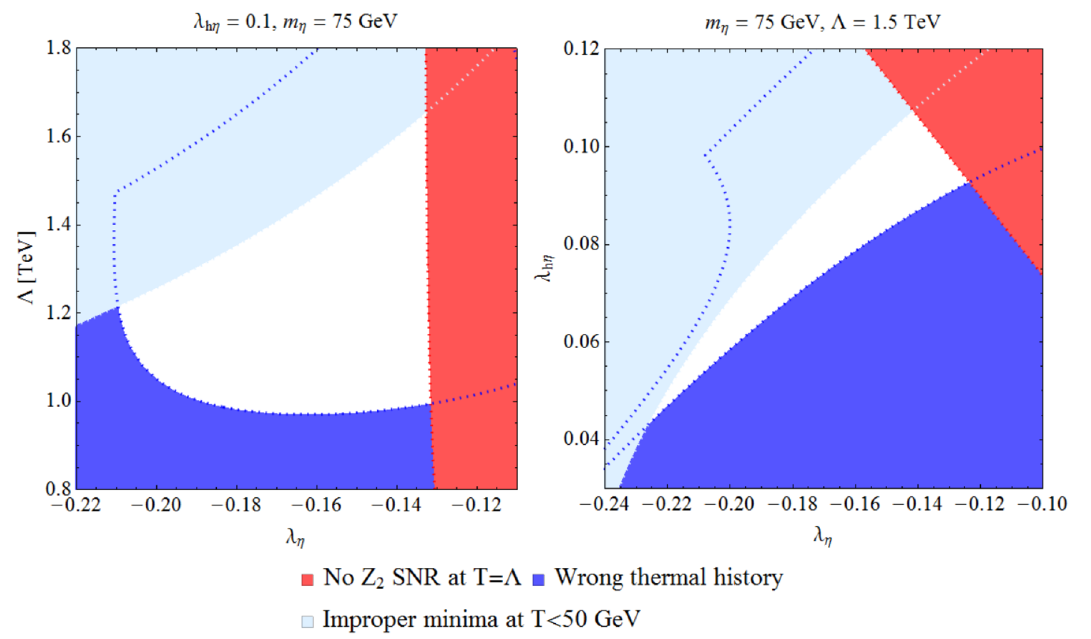
Figure 1 . Visualization of the constraints that we impose in our analysis. The dotted lines represent the boundaries of each of the excluded regions mentioned under the figures. In both panels the singlet mass has been set to m η = 75 GeV, whereas in the left (right) panel we fix λ hη = 0 . 1 ( Λ = 1 . 5 TeV) and vary λ η and Λ ( λ η and λ hη ). See text for the explanation of the